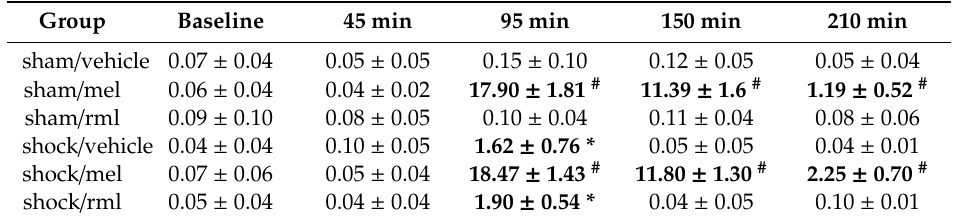
Table 2. Plasma melatonin content [ng / mL].